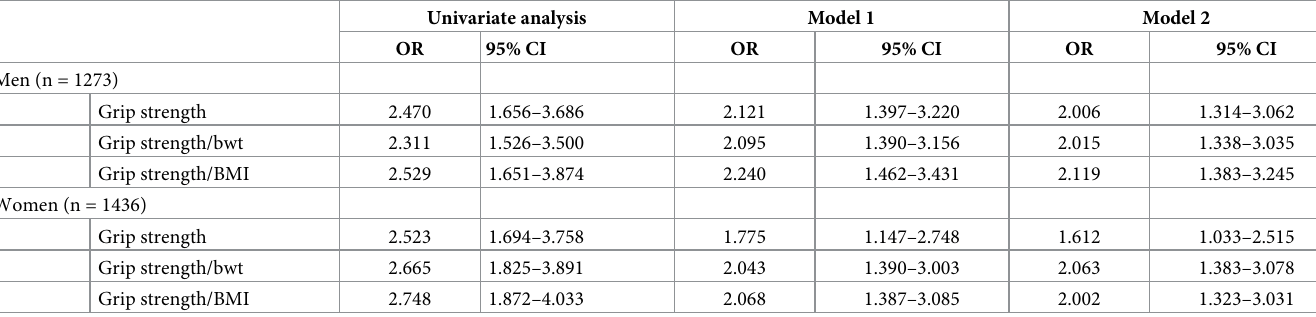
Table 3. Odds ratios of poor grip strength and poor normalized grip strength for poor quality of